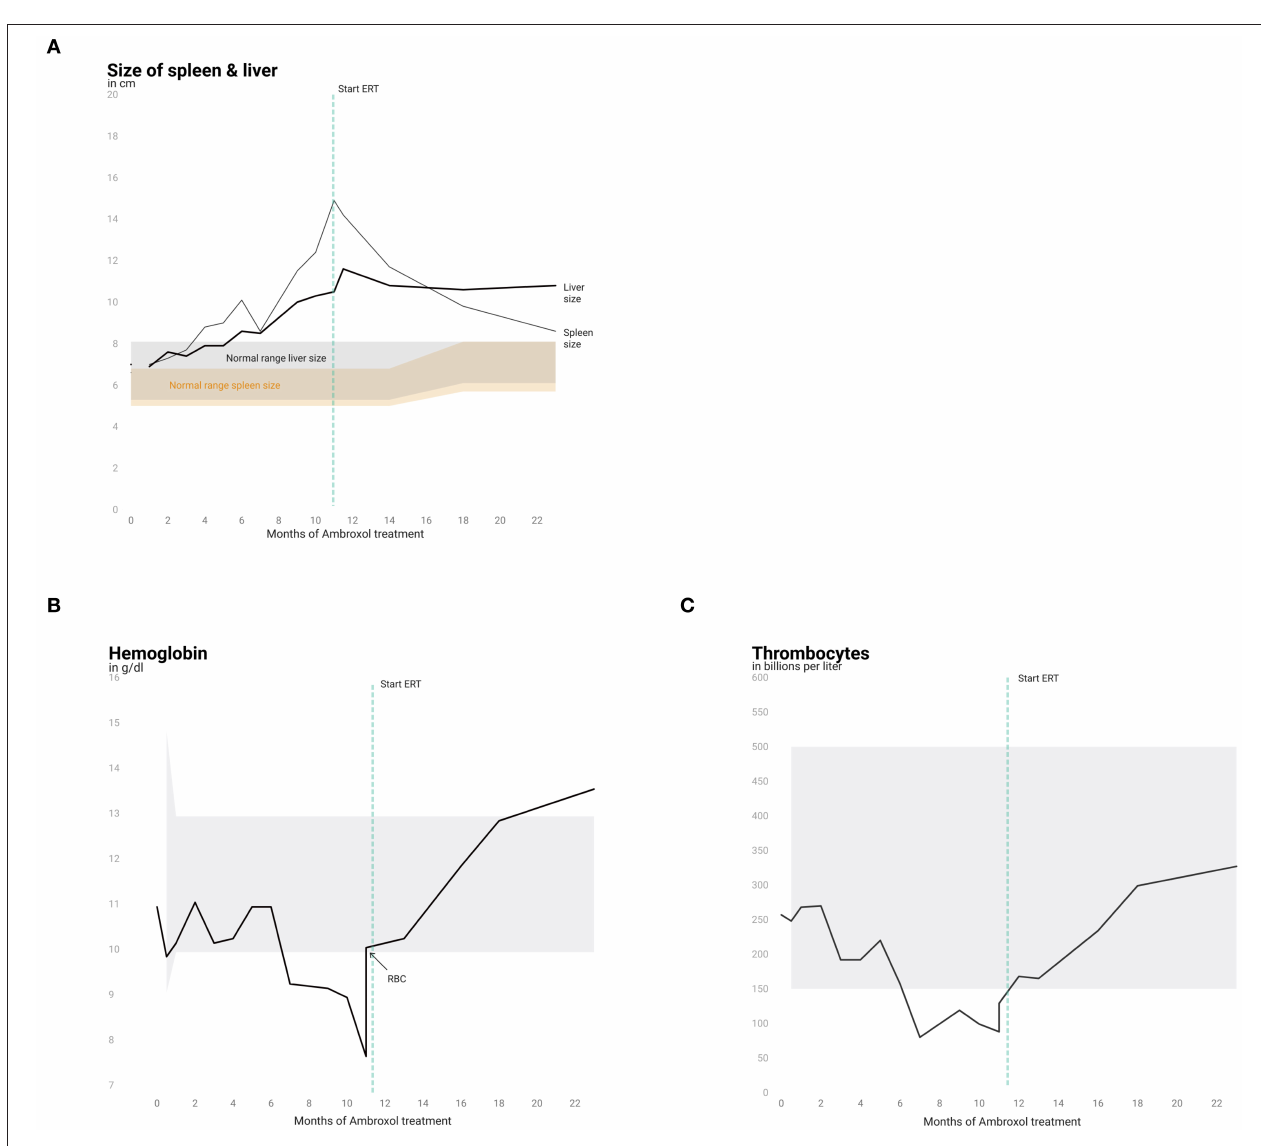
FIGURE 1 | Liver and spleen size and hematological parameters. Progression of spleen and liver size (A) and analysis of hemoglobin (B) and thrombocytes (C) over the course of 22 months. Normal ranges are shown in gray (liver, hemoglobin and thrombocytes) and in orange for spleen